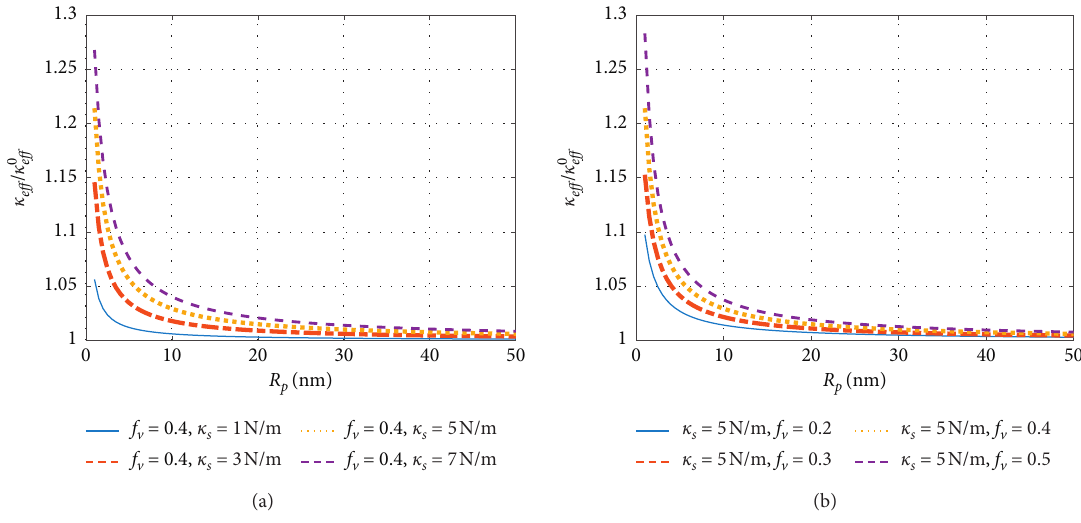
Figure 4: Nanoscale effect on bulk modulus as a function of (a) κ